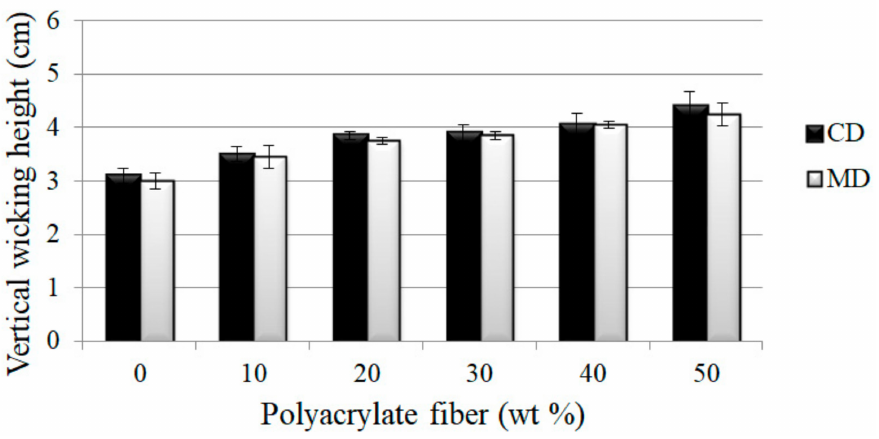
Figure 4. Wicking height of PT nonwoven composites as related to polyacrylate fiber content and fiber orientation (MD, CD).